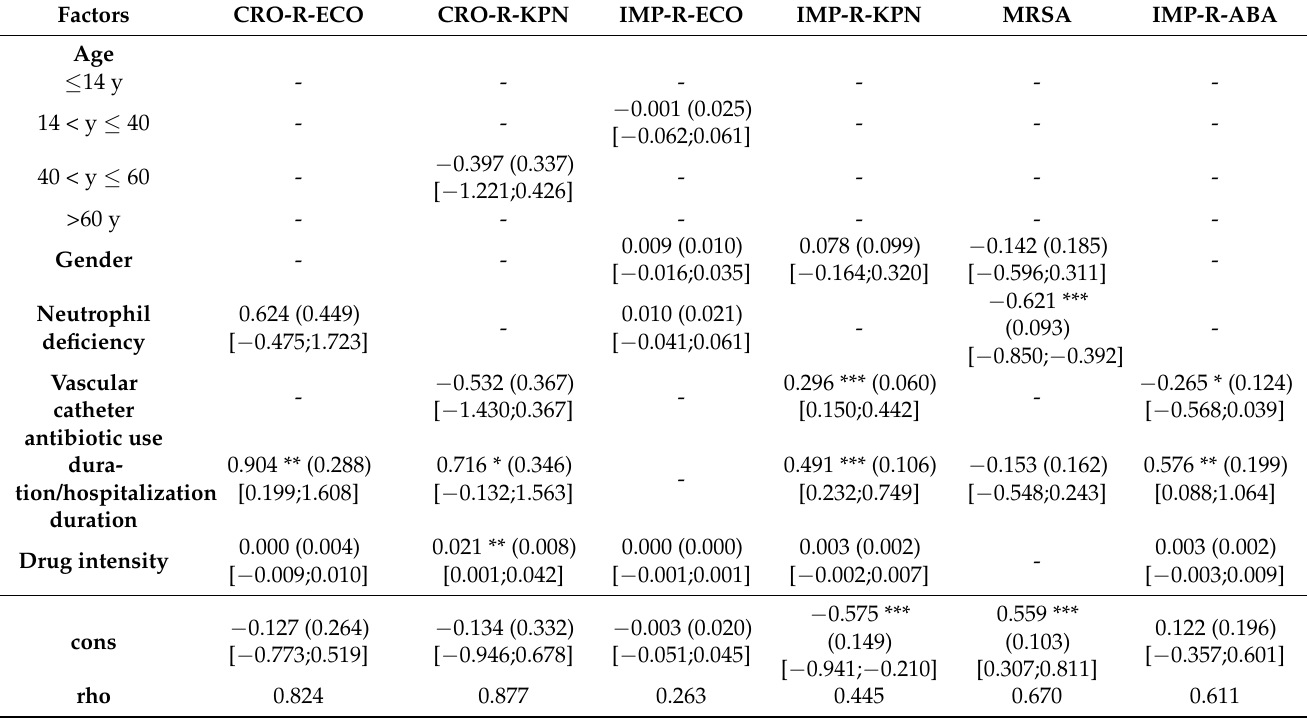
Table 5. Results of panel model analysis for bacterial bloodstream infection.